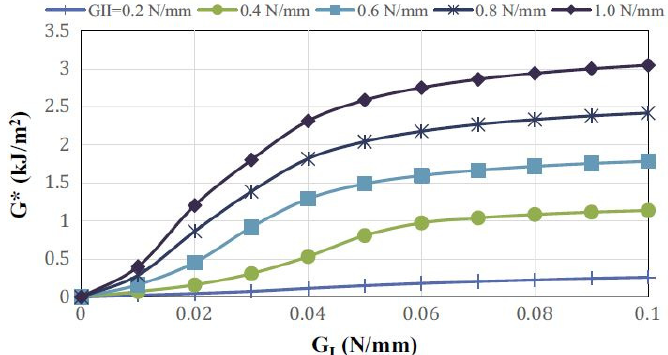
Figure 31. E ff ect of z-Pin / laminate interface mode I and II fracture toughness on the mode I apparent fracture toughness of the total z-Pinned laminate [29].